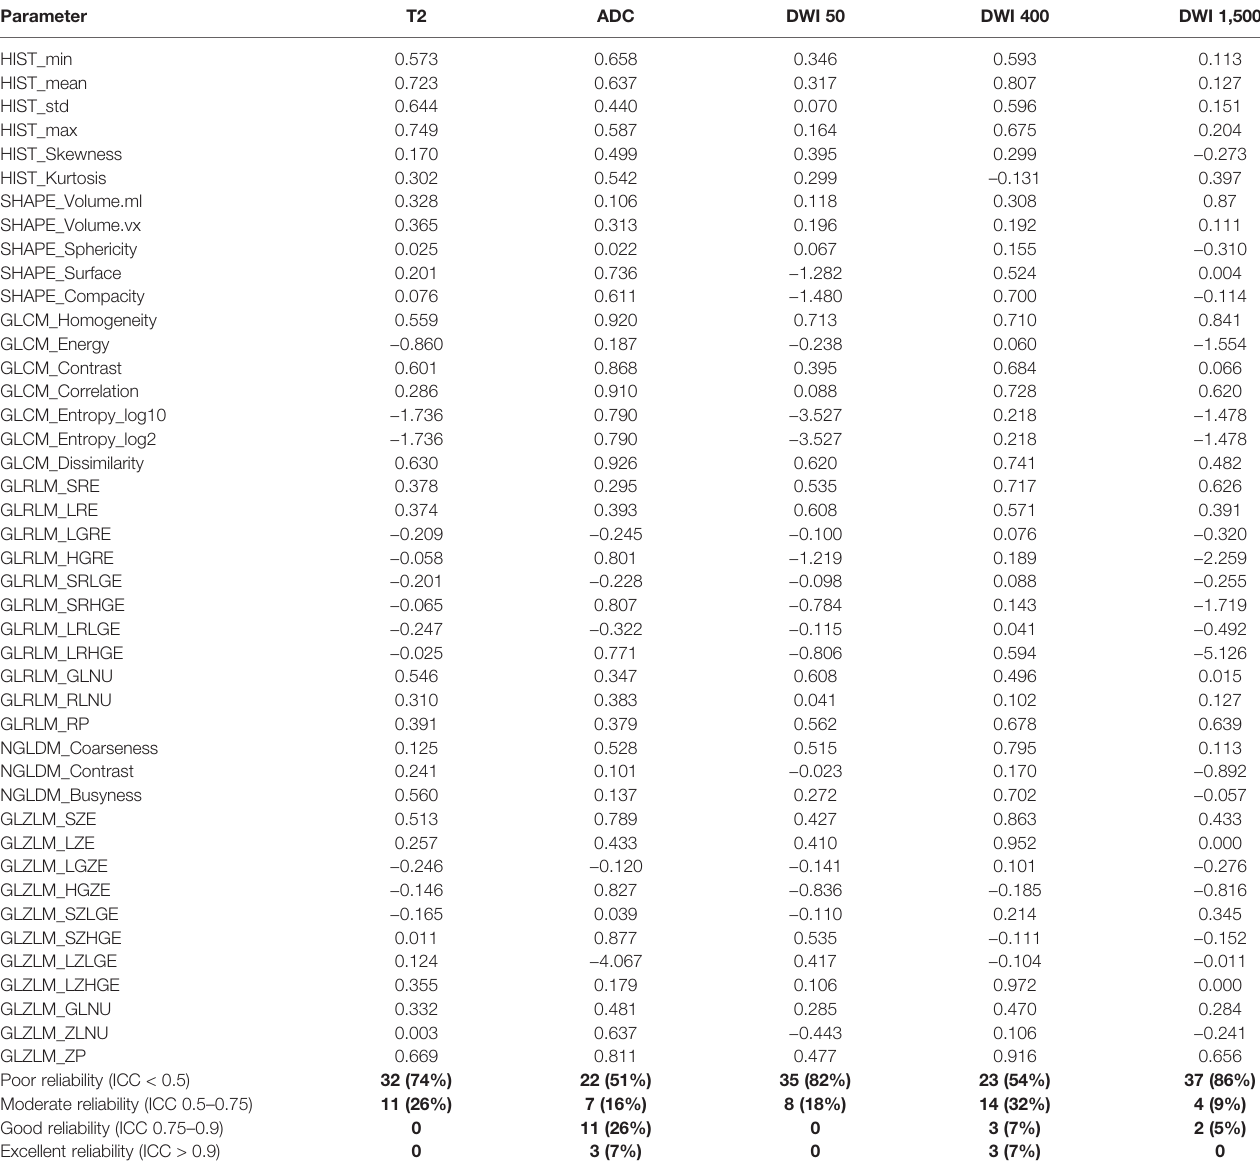
TABLE 2 | Intraclass coef fi cient correlation (ICC) of the different texture features in the different mrMRI sequences.